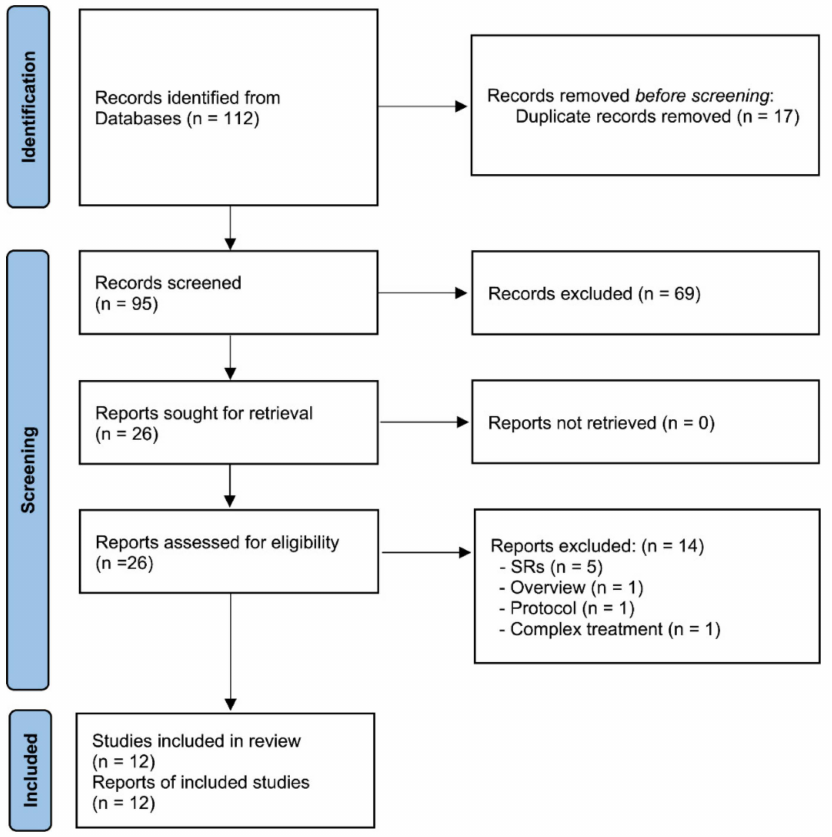
Figure 1. Flow chart of study selection. AT: acupuncture; SRs: systematic